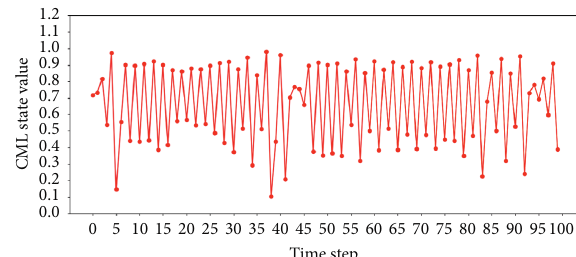
Figure 1: Without disturb R CML state value change of the Dongchuan Road station by time